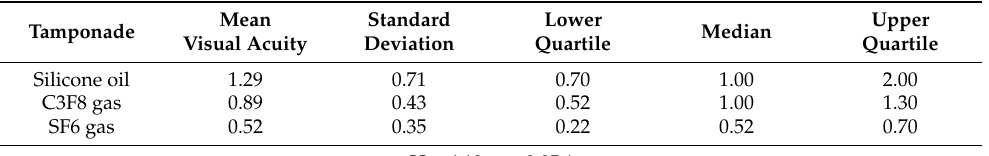
Table 1. Values of the postoperative visual acuity (mean, standard deviation, median, lower and upper quartile) in logMAR in eyes treated with different tamponades (silicone oil, SF6 gas, and C3F8 gas) in the group operated on with the 3D imaging